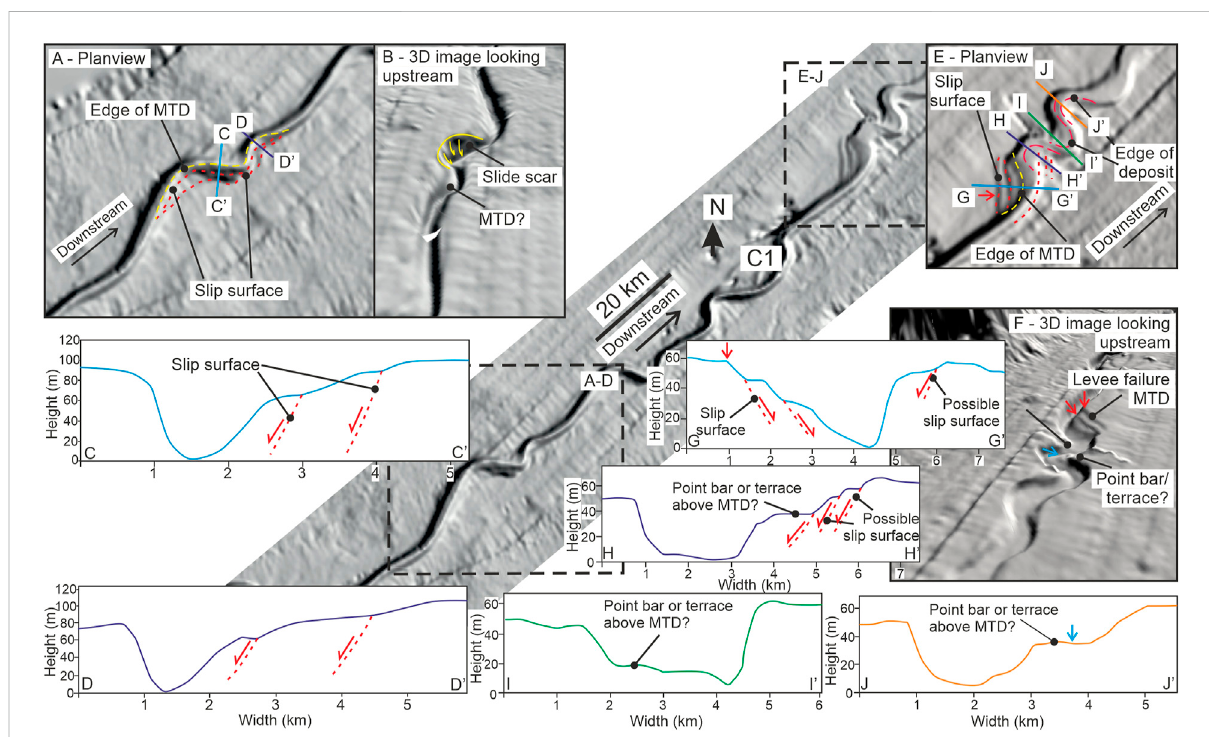
FIGURE 6 (A) Planview of terrace surfaces in a low sinuosity section of channel C1, with (B) showing a possible slide scar. (C,D) Cross-sectional pro fi les of terrace surfaces, with slip surfaces interpreted based on geomorphic signature. (E,F) Planview and 3D view of terrace surfaces. (G)